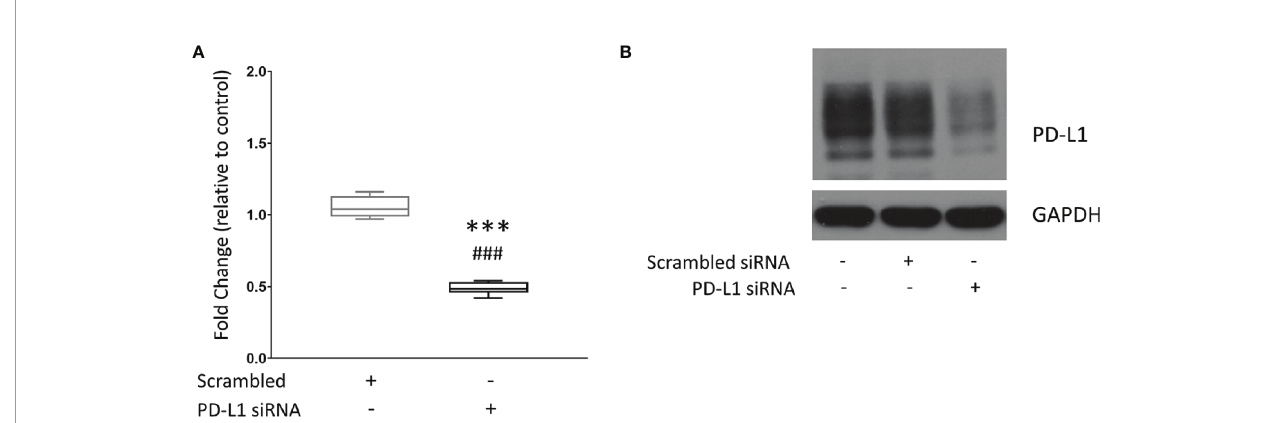
FIGURE 1 | Downregulation of PD-L1 in MDA-MB-231 cells. (A) Relative fold change of PD-L1 messenger RNA (mRNA) expression in MDA-MB-231 cells. Fold changes were normalized to untreated cells. Values are represented in box and whisker format with minimum to maximum values from 4 – 7 independent experiments. (B) Representative immunoblot assays of PD-L1 (top) and GAPDH (bottom) following PD-L1 siRNA dextran NP incubation. MDA-MB-231 cells were untreated (control) or transfected with either 100 nM scrambled siRNA/dextran, or 100 nM PD-L1 siRNA/dextran (N/P = 15). ***p ≤ 0.001 compared to untreated cells. ### p ≤ 0.001 compared to cells transfected with scrambled